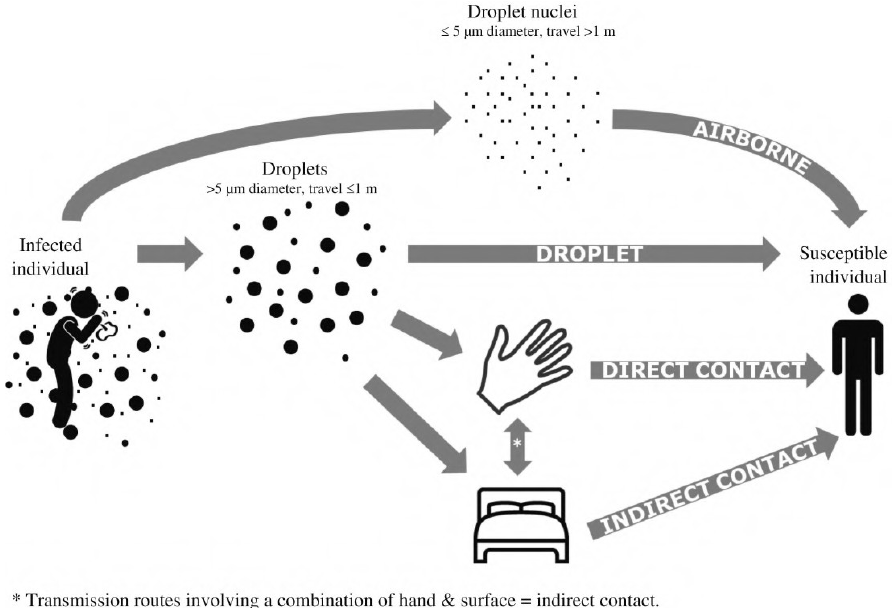
Figure 2. Schematic representation of how respiratory viruses spread through droplets (adapted with permission from Otter et al. [15]).